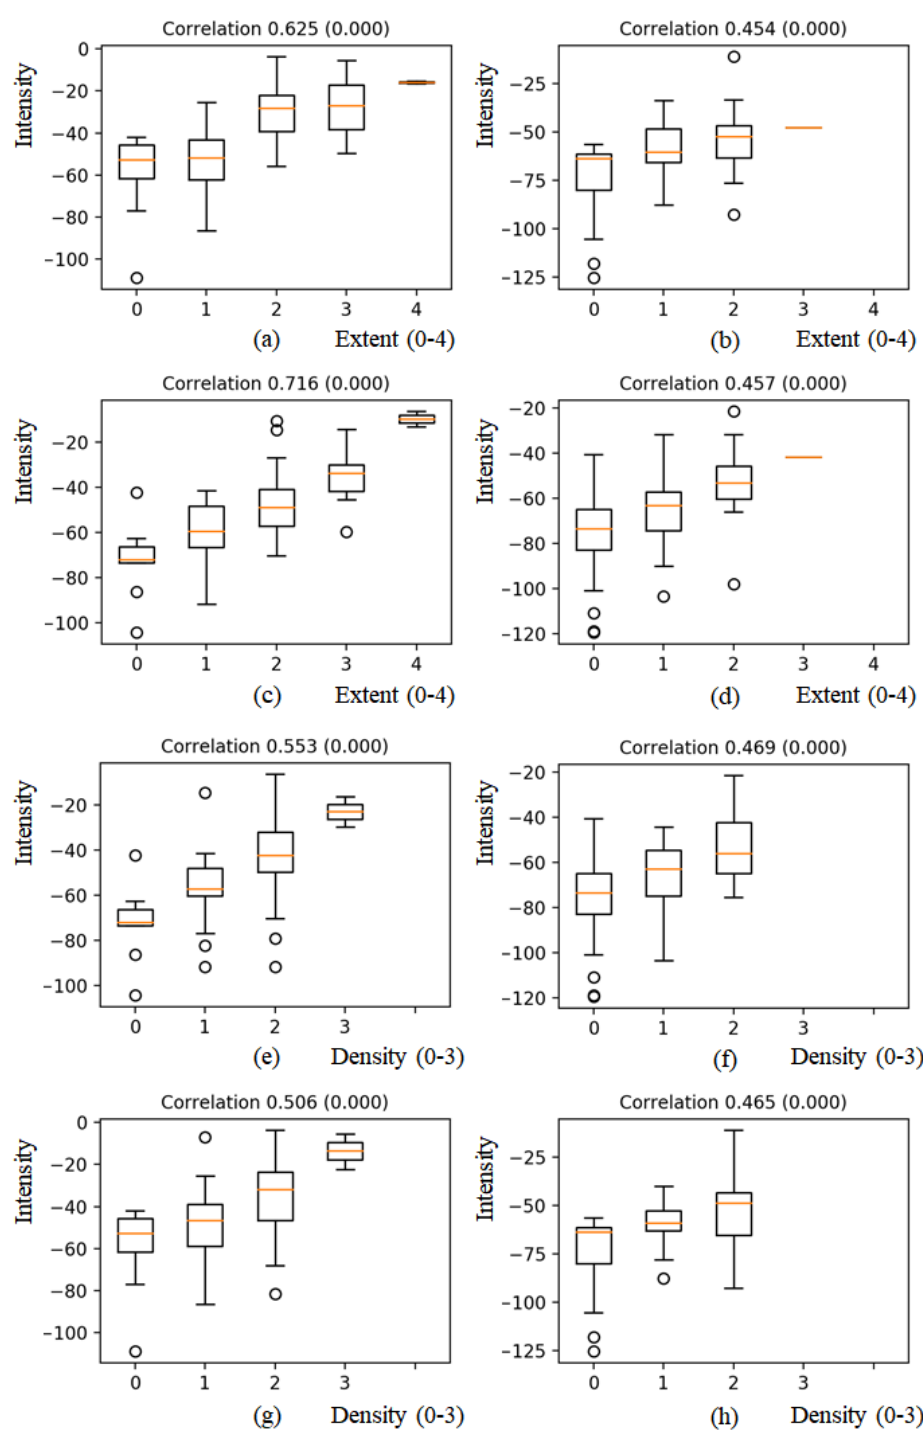
Figure 5. Boxplots of mean intensities with extent scores (0–4) and density scores (0–3) of pulmonary opacities for four-regions. ( a ) and ( e ) RUR, ( b ) and ( f ) LUR, ( c ) and ( g ) RLR, ( d ) and ( h ) LLR. For each region, the mean intensity increased as the extent and density scores increased.